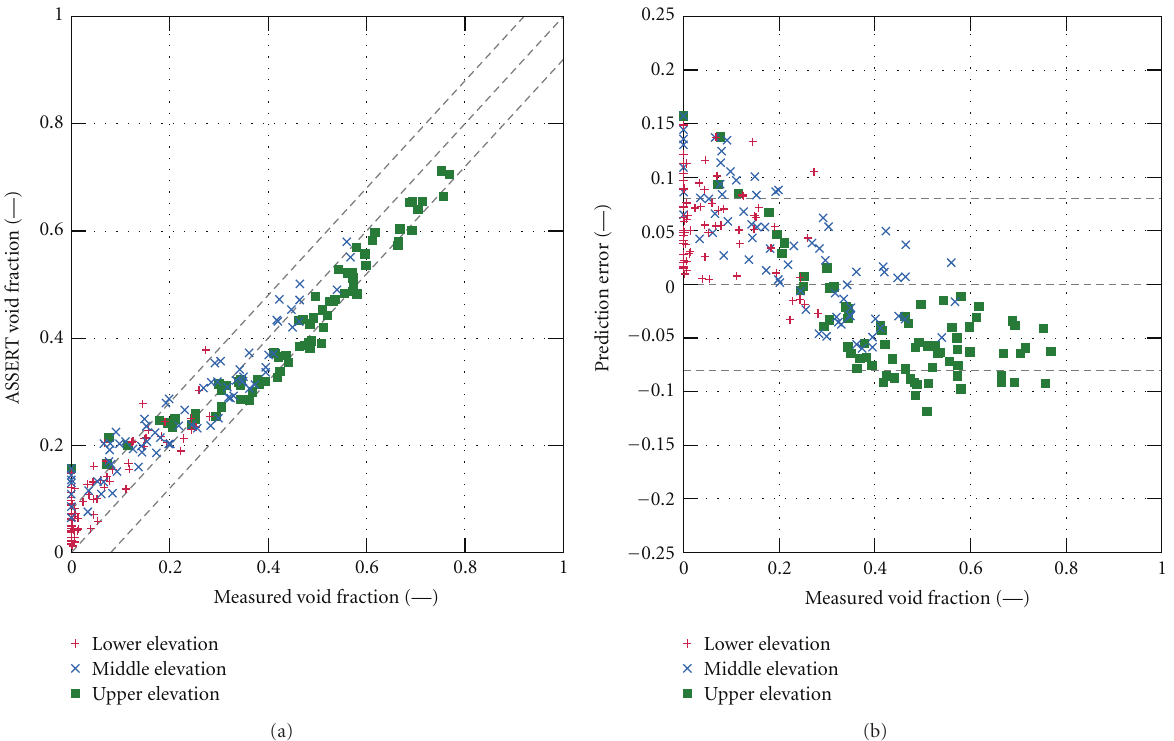
Figure 8: Steady state void fraction results for bundle test series B5. Error bands displayed correspond to 2 σ exp = 0 . 08.